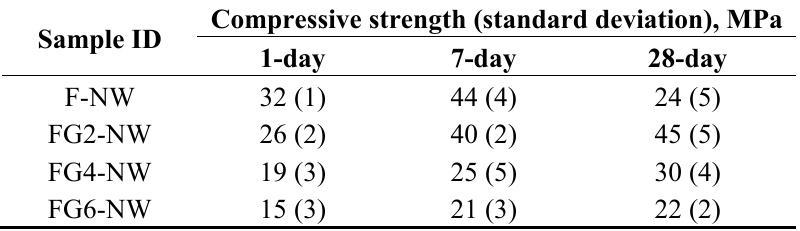
Table 3. Results from the compressive strength